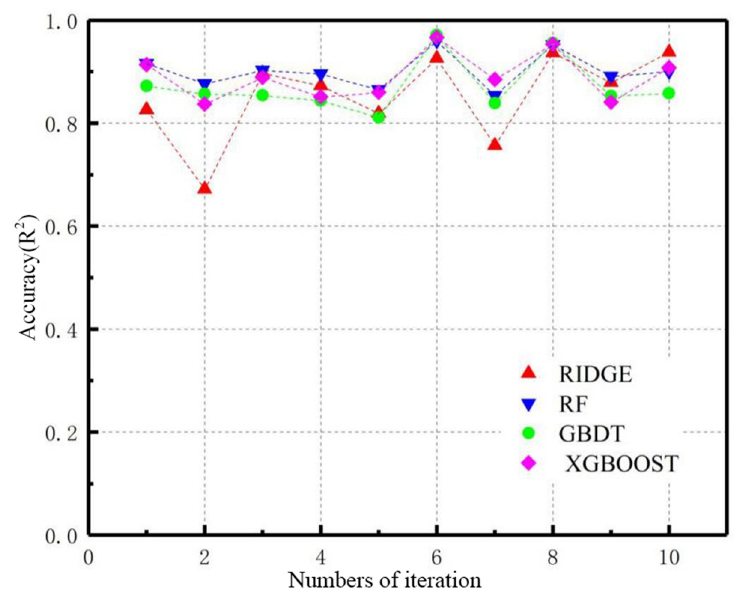
Figure 3. The R 2 prediction results of nine different machine learning algorithms.